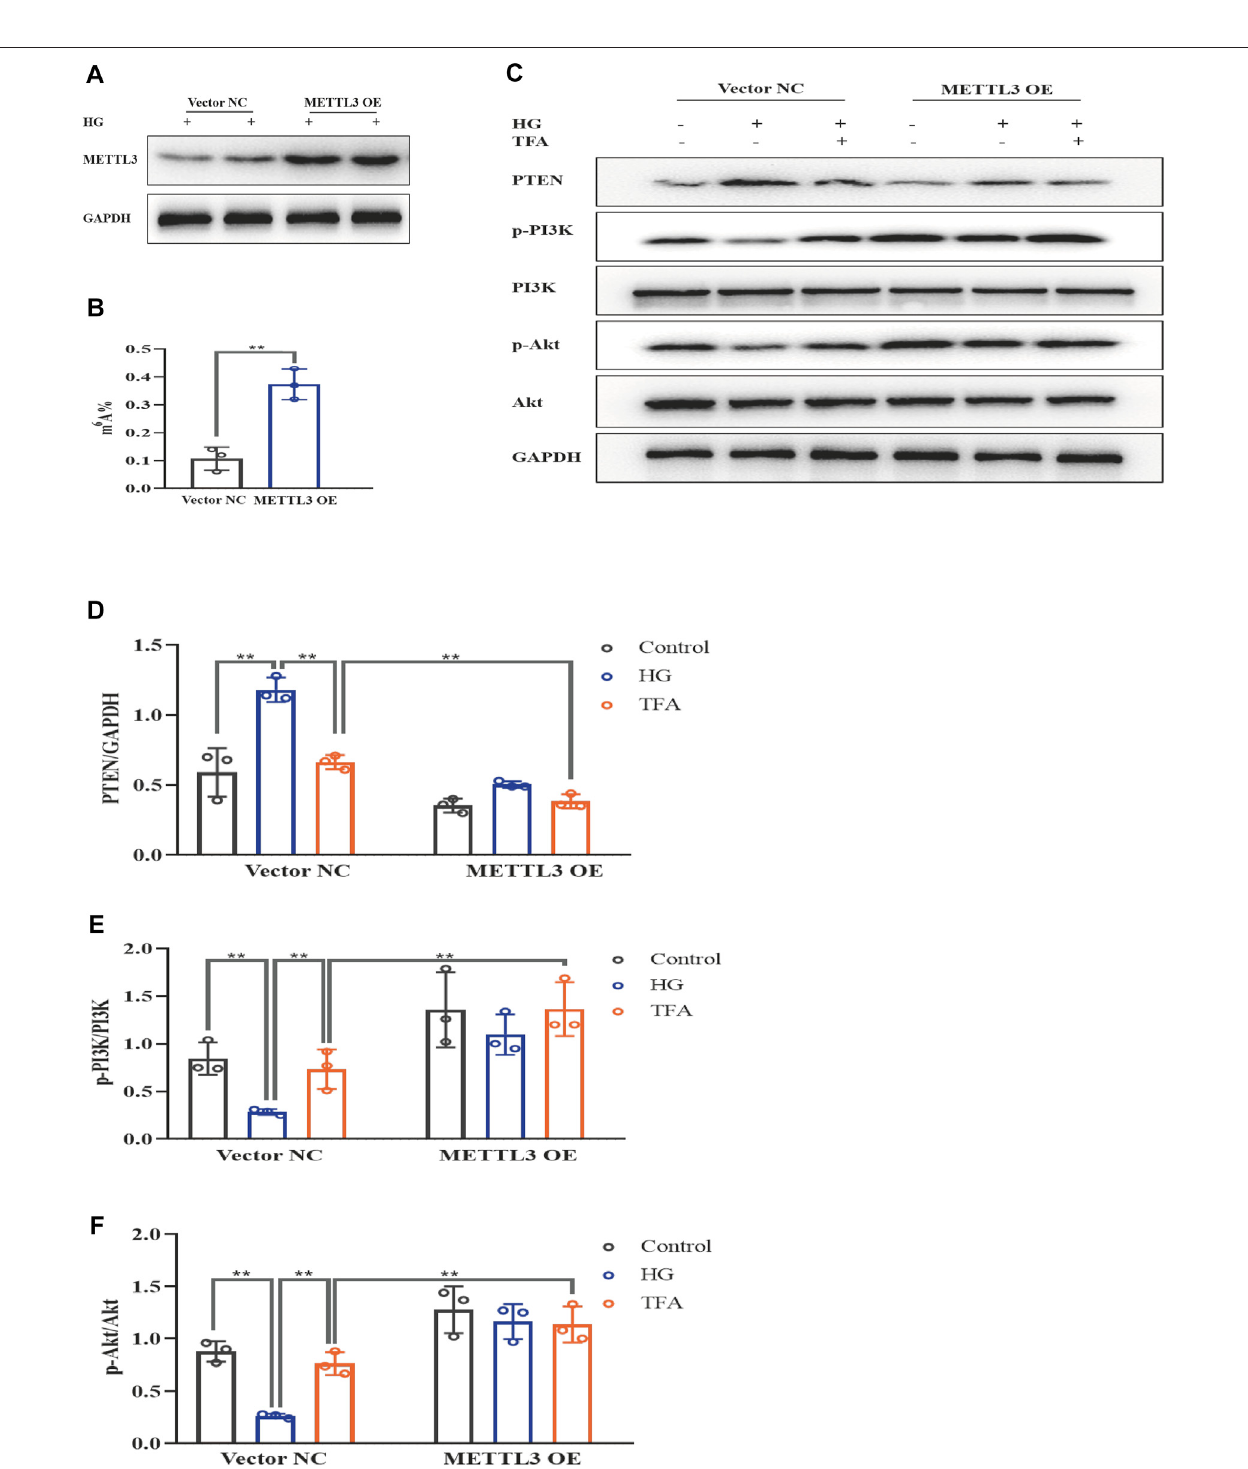
FIGURE 8 | TFA regulated the PTEN/PI3K/Akt signaling pathway in a METTL3-dependent manner via m 6 A modi fi cation in HG-af fl icted MPC-5 cells with overexpressed METTL3. (A) WB analysisofMETTL3in cultured MPC-5cells transfected induplicates with aNC vector ora METTL3OEvector for24 h and exposed to HG (30 mM) for 48 h; (B) Quanti fi cation of m 6 A levels in cultured MPC-5 cells transfected in duplicates with a NC vector or METTL3 OE vector for 24 h and exposed to HG (30 mM) for 48 h, as determined by a m 6 A RNA methylation quanti fi cation kit; (C) WB analysis of PTEN, p-PI3K, PI3K, p-Akt, and Akt, in cultured MPC-5 cells transfectedwithNCor METTL3OEvectorsfor24 h, followingbyexposure toHGat 30 mMfor48 hwithorwithoutTFA(20 μ g/ml)for24 h; (D) PTENwasquanti fi edby densitometry; (E) p-PI3K was quanti fi ed by densitometry; (F) p-Akt was quanti fi ed by densitometry. Data are expressed as mean ± S.D., ( n (cid:2) 3). * p < 0.05, ** p < 0.01. Abbreviations: TFA, total fl avones of Abelmoschus manihot ; PTEN, phosphate and tension homology; PI3K, phosphatidylinositol 3-kinases; Akt, protein kinase B; METTL, methyltransferase-like; m 6 A, N6-methyladenosine; HG, high glucose; MPC-5, mouse podocyte cell-5; WB, western blotting; NC, negative control; OE, overexpression; p-PI3K, phosphorylated-phosphatidylinositol 3-kinase; p-Akt, phosphorylated-protein kinase B. Frontiers in Pharmacology |